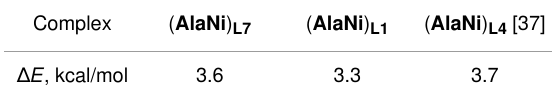
Table 2: The calculated (PBE-D4 /def2-SVP) energy differences be- tween the ᴅ - and ʟ -( AlaNi ). Complex